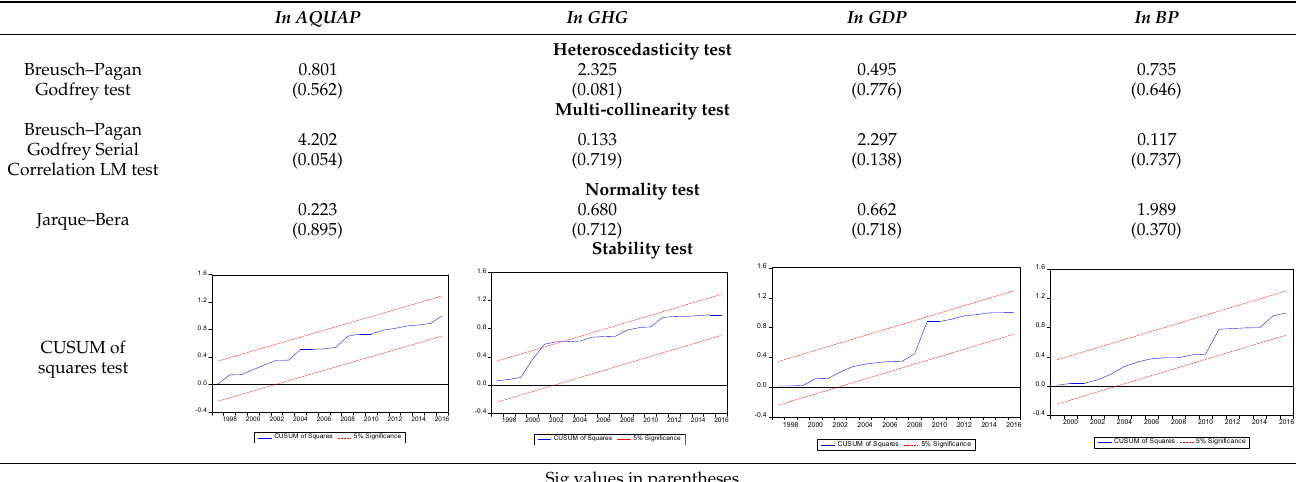
Table 6. Diagnostic tests.